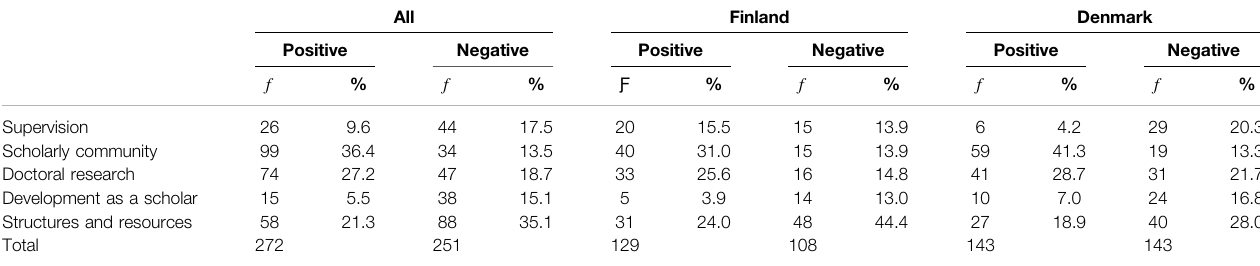
TABLE 3 | Comparison between Denmark and Finland of the frequencies of positive and negative emotions in different aspects of doctoral experience.